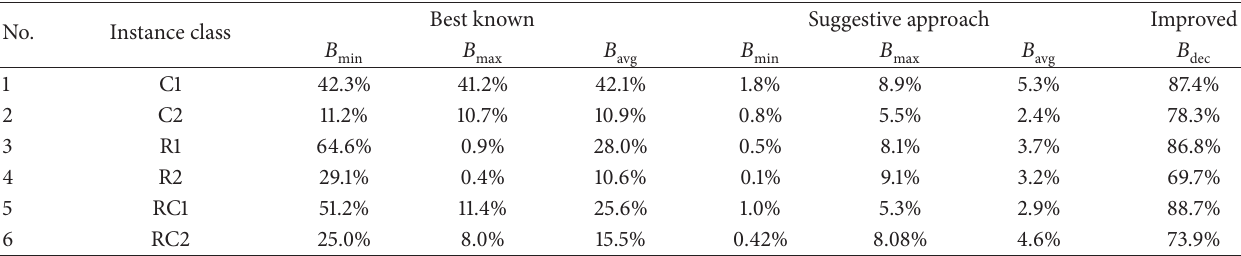
Table 4: Compared results of all